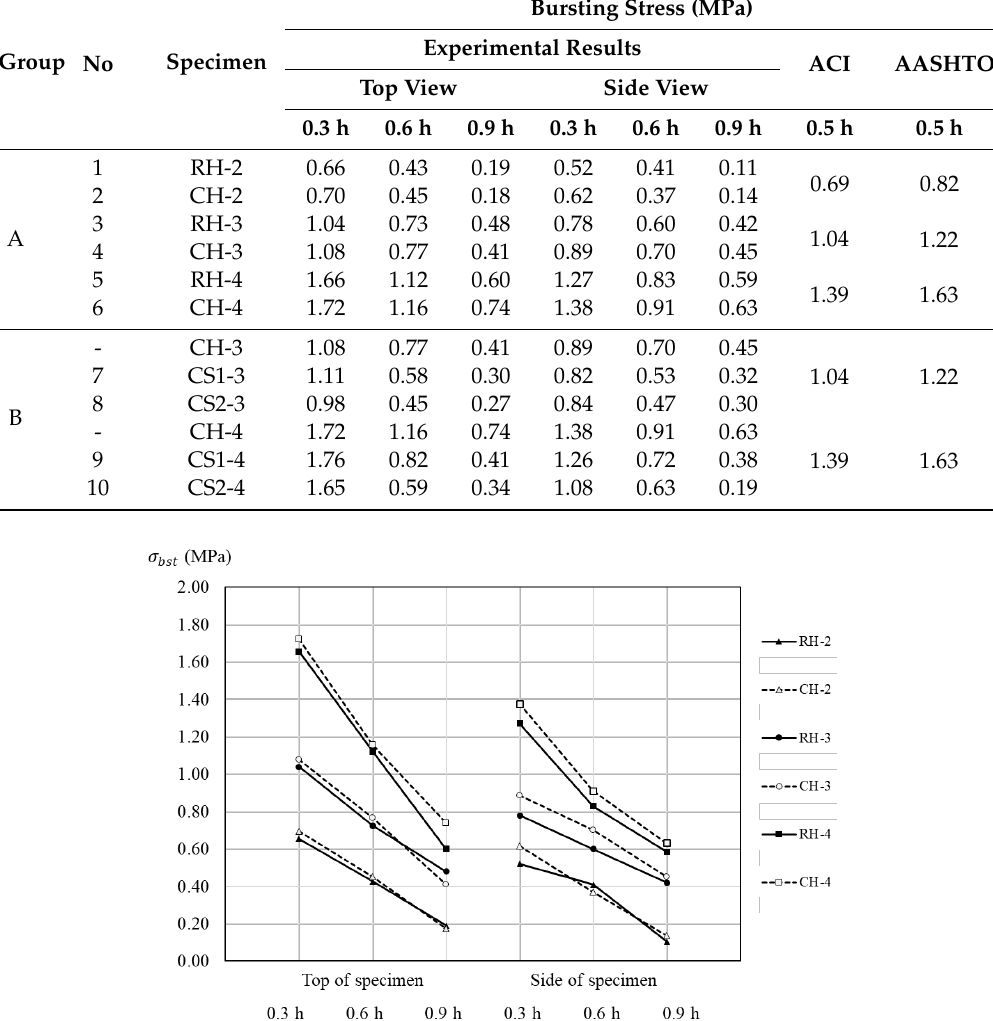
Table 2. Bursting stress at jacking force.